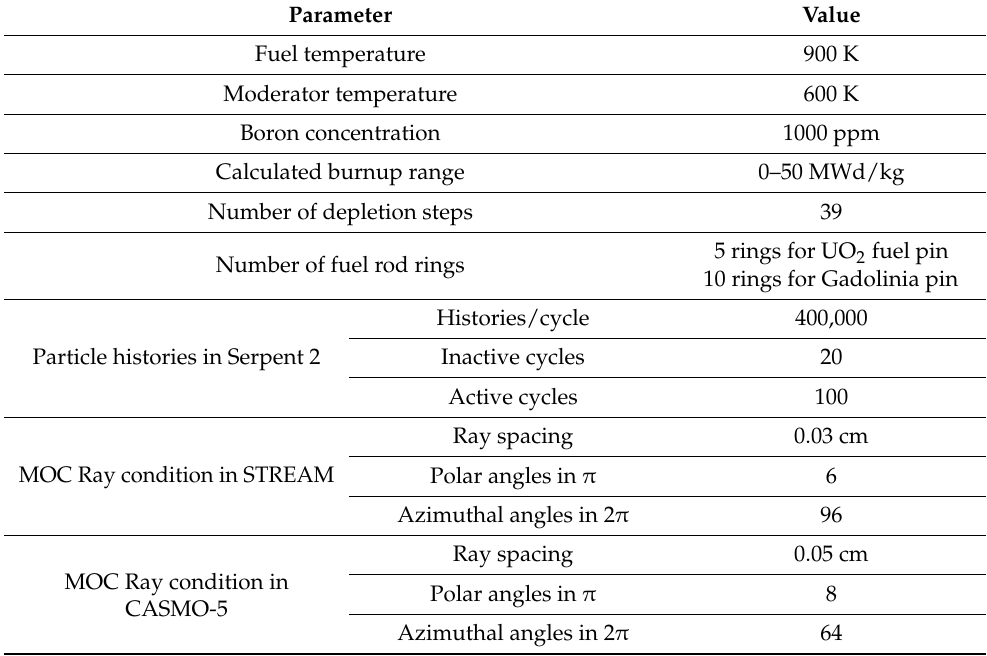
Table 3. Calculation condition for sensitivity